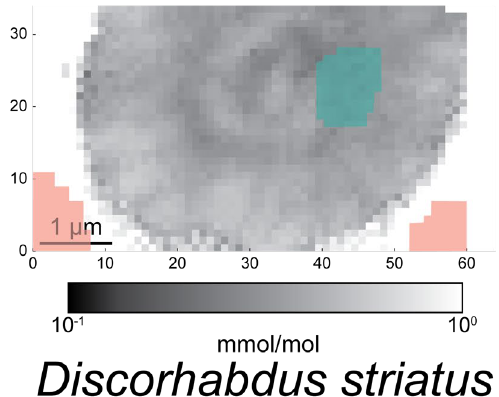
Supplementary Figure 2. Selected zone (green) and background (red) used for calculations in Table 1 over Sr/Ca (mmol/mol) maps for C. crassus , W. contracta and D. striatus